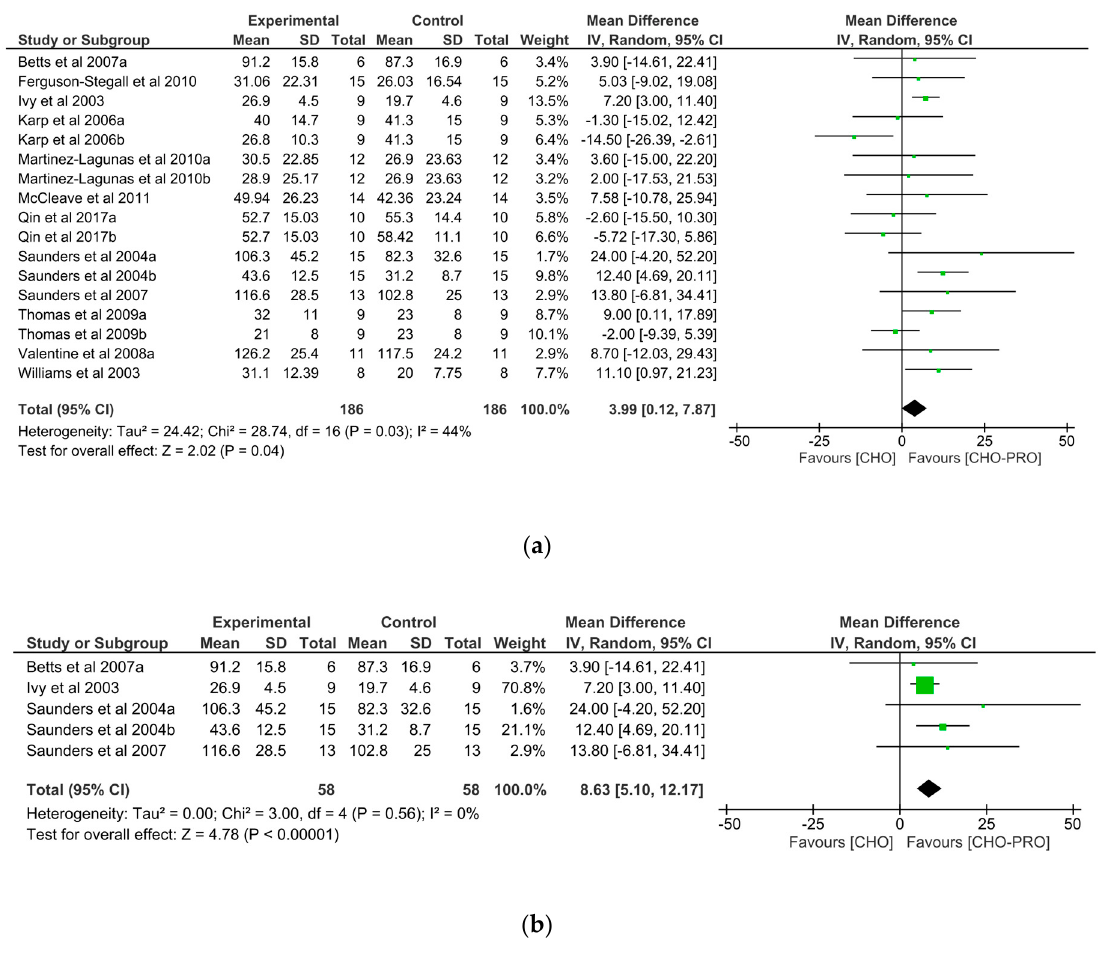
Figure 9. ( a ) E ff ect of a non-isocaloric supplementation of CHO-PRO vs. CHO on TTE performance. CI: confidence interval; MD: mean di ff erence. ( b ) E ff ect of a carbohydrate-matched supplementation of CHO-PRO vs. CHO on TTE performance. CI: confidence interval; MD: mean di ff erence. Nutrients 2020 , 12 , x FOR PEER REVIEW